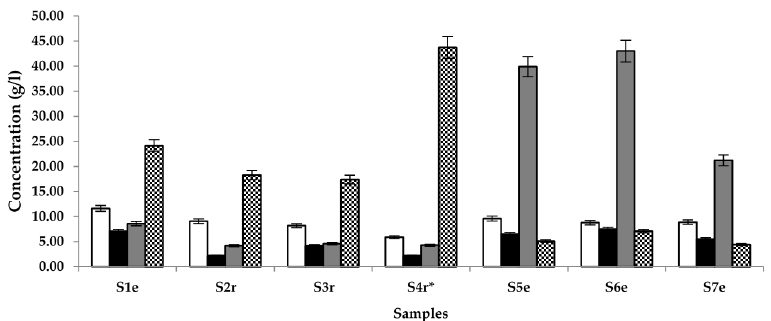
Figure 1. Quantification of the main compounds of palm wine fermentation, namely acetic acid ( □ ), lactic acid ( ■ ), ethanol ( ) and glucose ( ) in samples (S) 1–7, obtained from different locations (r = Raphia sp.; e = Elaeis sp.; * = sample supplemented with S. gabonensis ).